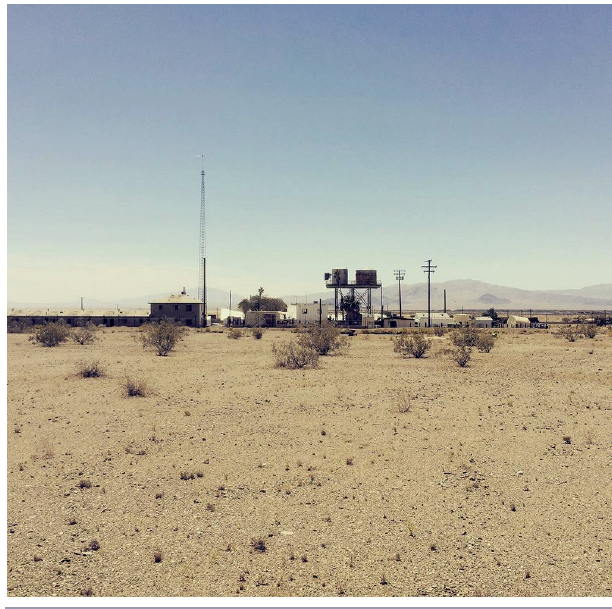
Fig. 1. The venue where Drylab 2023 took